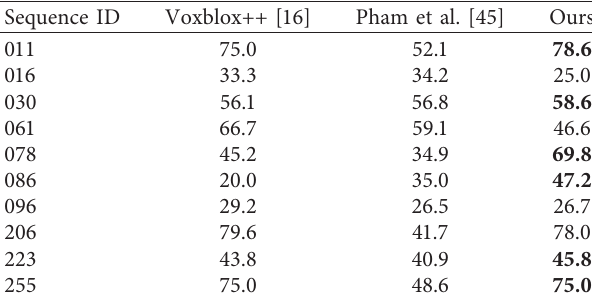
Table 3: Comparison to the 3D semantic instance-segmentation approach from Voxblox++ [16] and Pham et al. [45] on class- averaged mAP